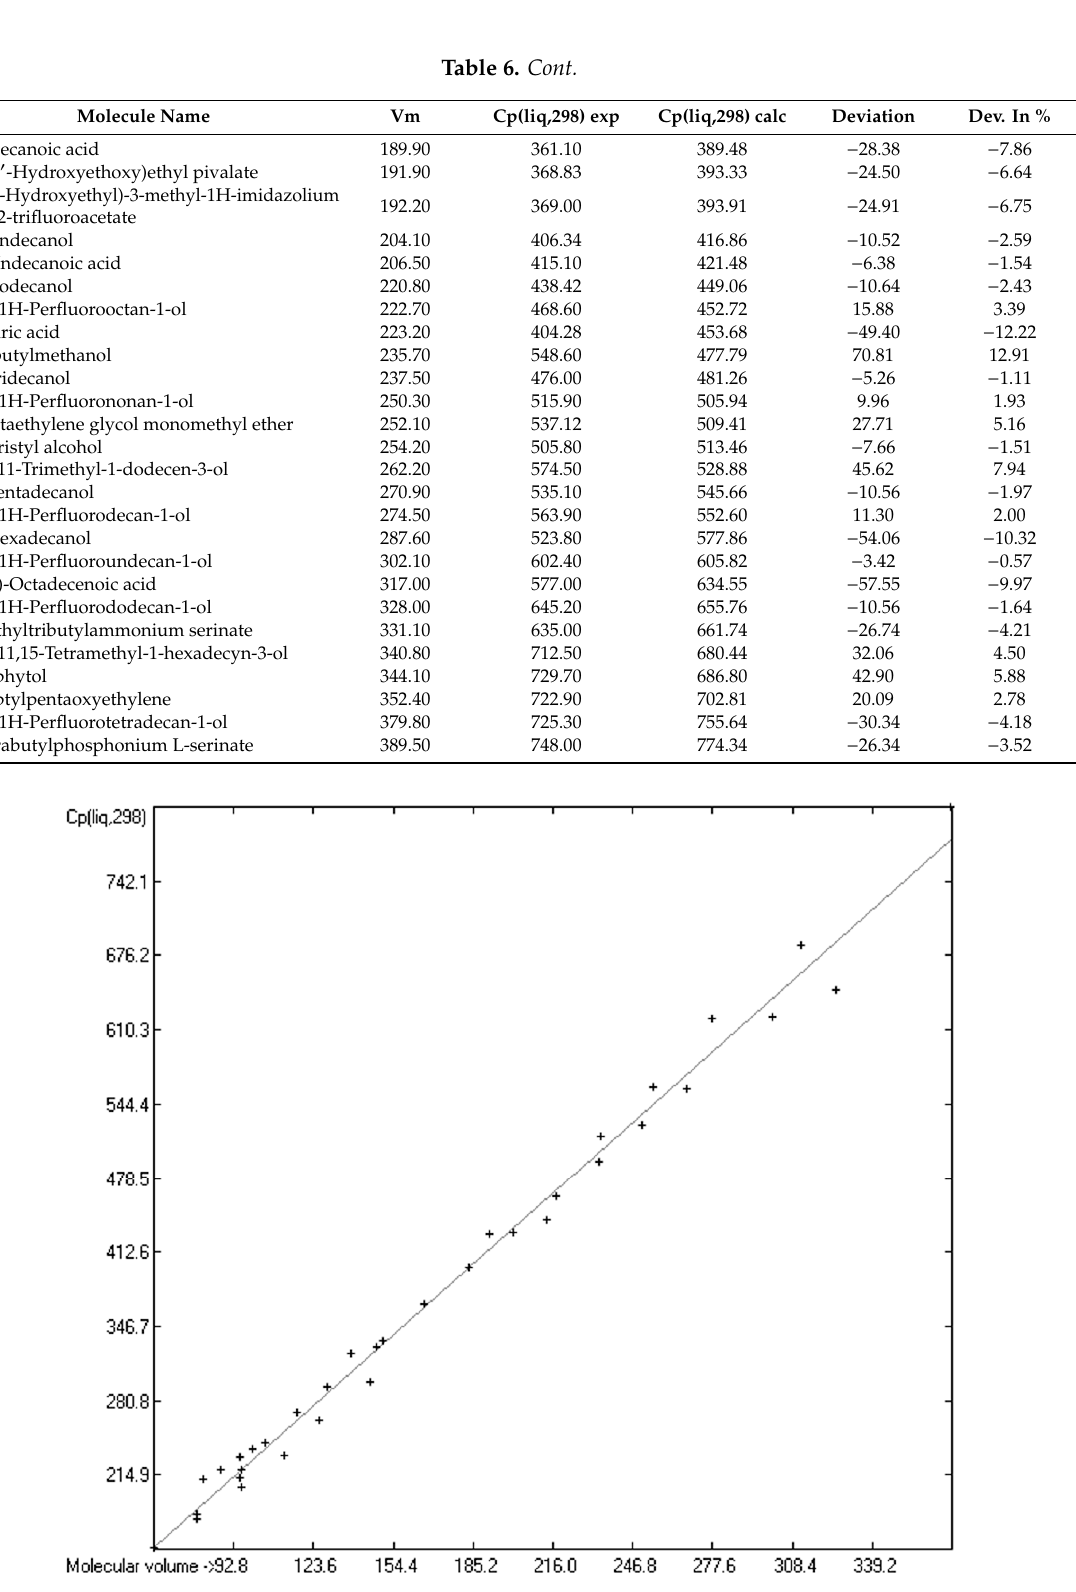
Figure 9. Correlation of molecular volumes with Cp(liq) at 298.15 K of polyols and polyacids. (N = 36, R 2 = 0.9910, σ = 16.03 J/mol/K, MAPD = 3.77%, regression line: intercept = 23.5782, slope = 2.0422, Value range from 149.8 to 807.5 J/mol/K). Table 7. Molecular volumes Vm (in A 3 ), experimental and Equation (4)-calculated Cp(liq.298) (in J/mol/K) of 36 polyols and polyacids.